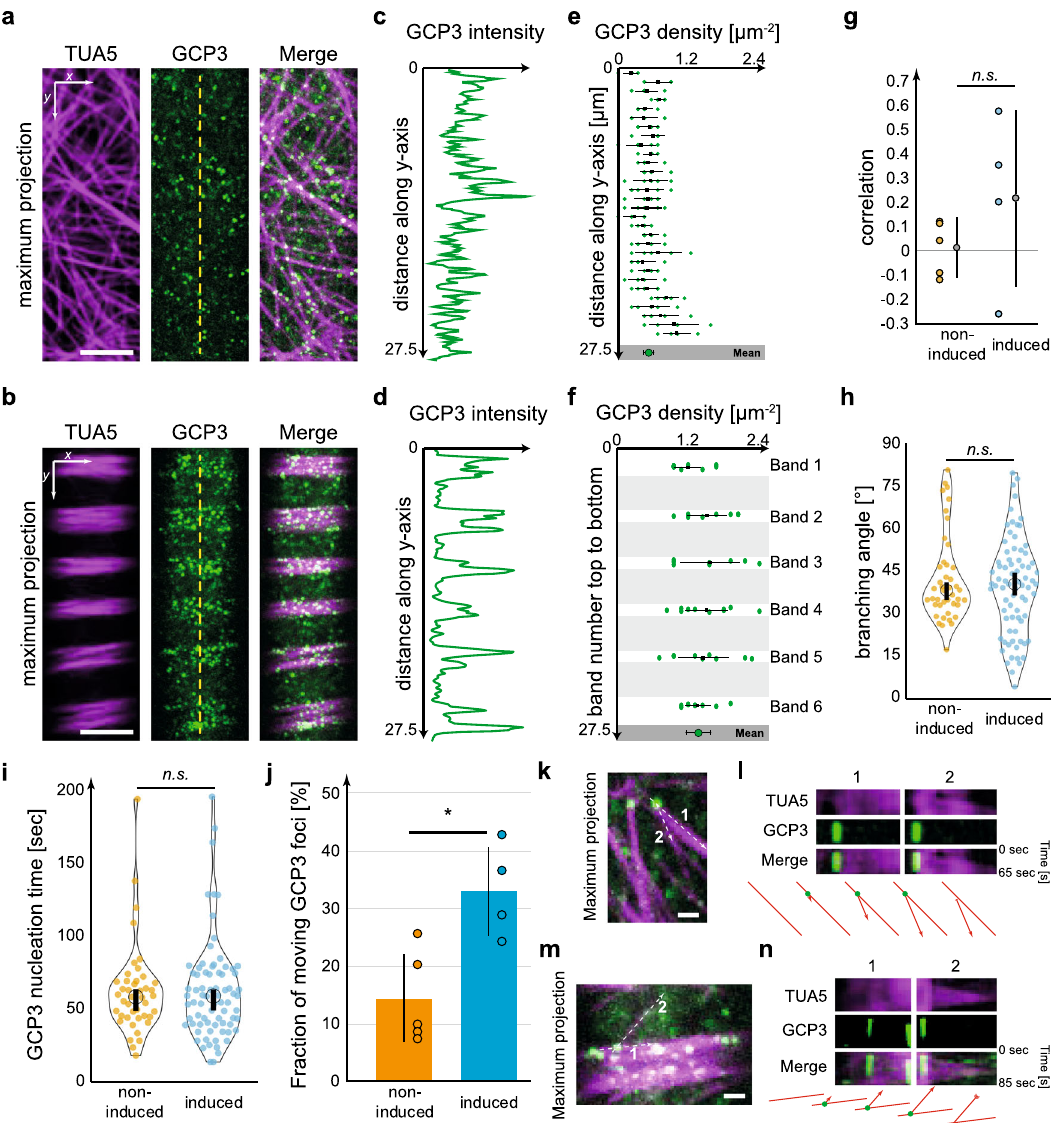
Fig. 3 GCP3 nucleation complexes distribute evenly across developing bands during proto-xylem formation. a , b Maximum projections of dual-labelled mCH-TUA5 GCP3-GFP in non-induced cells ( a ) and during PX formation ( b ). Scale bar = 5 µ m. c , d Intensity along the lines in a and b . e , f Cortical GCP3 density along the y -axis of non-induced cells ( e ) and in microtubule bands of induced cells ( f ). Each dot refers to a density measurement, black squares and lines represent means± SD for each section of cortex. Pooled measurements (bottom) average to a GCP3 density of 0.56 ± 0.19 foci per µ m 2 (mean ± SD, 155 measurements, 5 cells) in non-induced cells ( e ) and to 1.41 ± 0.43 foci per µ m 2 (56, 4, p < 0.0001, Welch ’ s unpaired, two-sided t -test) in induced cells. g GCP3 intensity is uncorrelated along the y -axis indicating an even distribution of GCP3 foci across bands (mean ± 95% con fi dence intervals; p > 0.91, Welch ’ s unpaired, two-sided t -test). h , i Branching angle and nucleation time of microtubules from GCP3 foci located on parent microtubules are identical in non-induced (orange) and induced cells (blue), respectively (means ± 95% con fi dence intervals, p > 0.37 and p > 0.97, for 43 and 76 new microtubules and GCP3s foci, from 5 and 4 cells, respectively). j Proportion of moving GCP3s in non-induced (orange) and induced (blue) cells (mean ± SD, 43 and 76 GCP3s from 5 non-induced and 4 induced cells, * p = 0.0142, Welch ’ s unpaired, two-sided t -test). k – n Maximum projections showing microtubules nucleated from parent microtubules in non-induced cells ( k ) and induced cells ( m ). Dashed lines indicate parent (1) and new (2) microtubules used to generate kymographs ( l , n ). Scale bar = 1 µ m. Panels l and n show kymographs of stationary GCP3s during nucleation of new microtubules for non-induced ( l ) and induced ( n ) cells. Below: schematic representation of the nucleations shown in the kymographs. red: microtubules, green: regardless of the type of nucleation mode (parallel, branched or microtubule band separation but does affect the fi delity and speed ‘ fuzzy branched ’ ; Supplementary Fig. 16 and Supplementary of this process, both in native and induced PX. Note 1). We next hypothesized that the main cause of delayed band formation in the ktn1-2 mutant could be the impaired Array orientation and anisotropy impact band formation in formation of well-aligned, anisotropic arrays prior and during the silico . To try to understand the KTN-induced changes in the band separation. To investigate this, we altered the initiation band separation process, we included KTN-based microtubule phase to generate a wider range of initial array anisotropies and severing at crossovers in our simulations 43 . We found that this orientation angles at the start of the separation phase. To this end, KTN activity had little impact on the separation process,